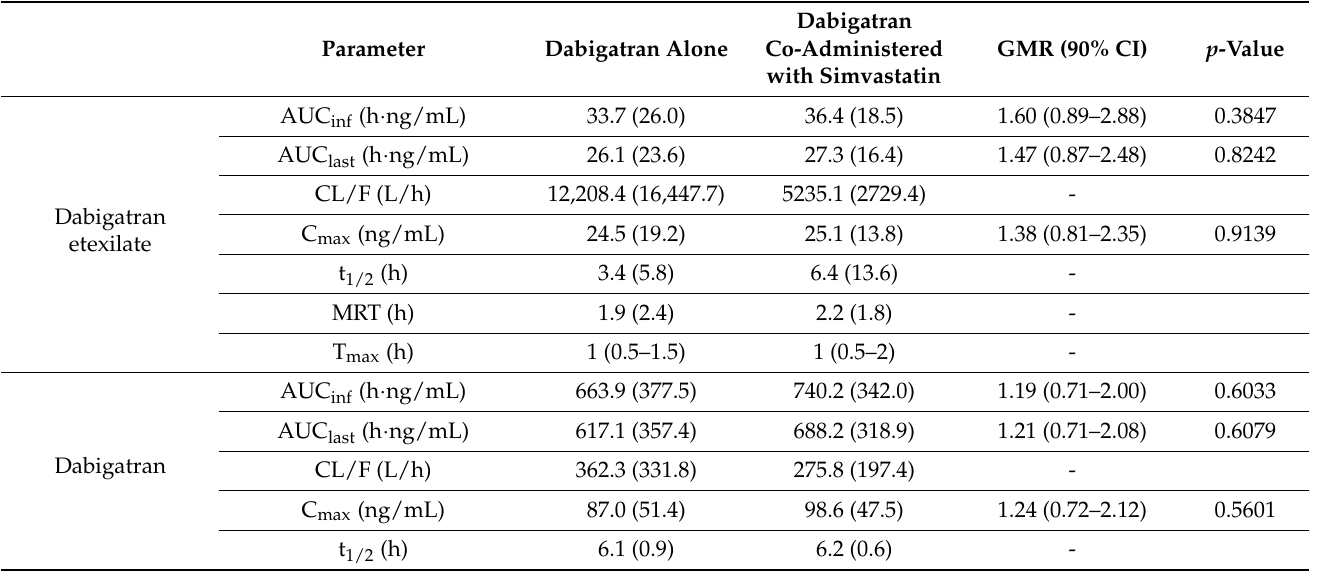
Figure 1. Mean plasma concentration profiles of ( A ) dabigatran etexilate, ( B ) dabigatran, and ( C ) dabigatran acylglucuronide after administration of 150 mg dabigatran etexilate with or without simvastatin. Table 1. Pharmacokinetic parameters of dabigatran etexilate, dabigatran, and dabigatran glucuronide before and after co-administration of simvastatin.